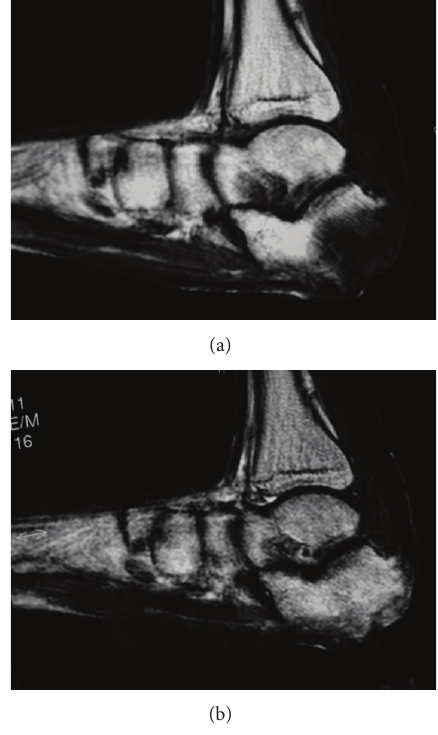
Figure 2: Magnetic resonance imaging of the preoperation. (a) T1-weighted sagittal imaging shows diffuse low signal intensity in posterior calcaneus. (b) T2-weighted sagittal imaging shows diffuse high signal intensity in the same region.